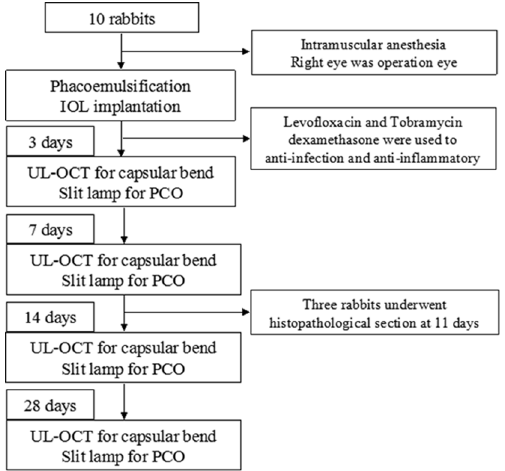
Fig 2. Flow chart of the experiment. Levofloxacin and tobramycin dexamethasone eye drop or oculentum were used for anti-infection and anti-inflammatory for at least 7 days after surgery.